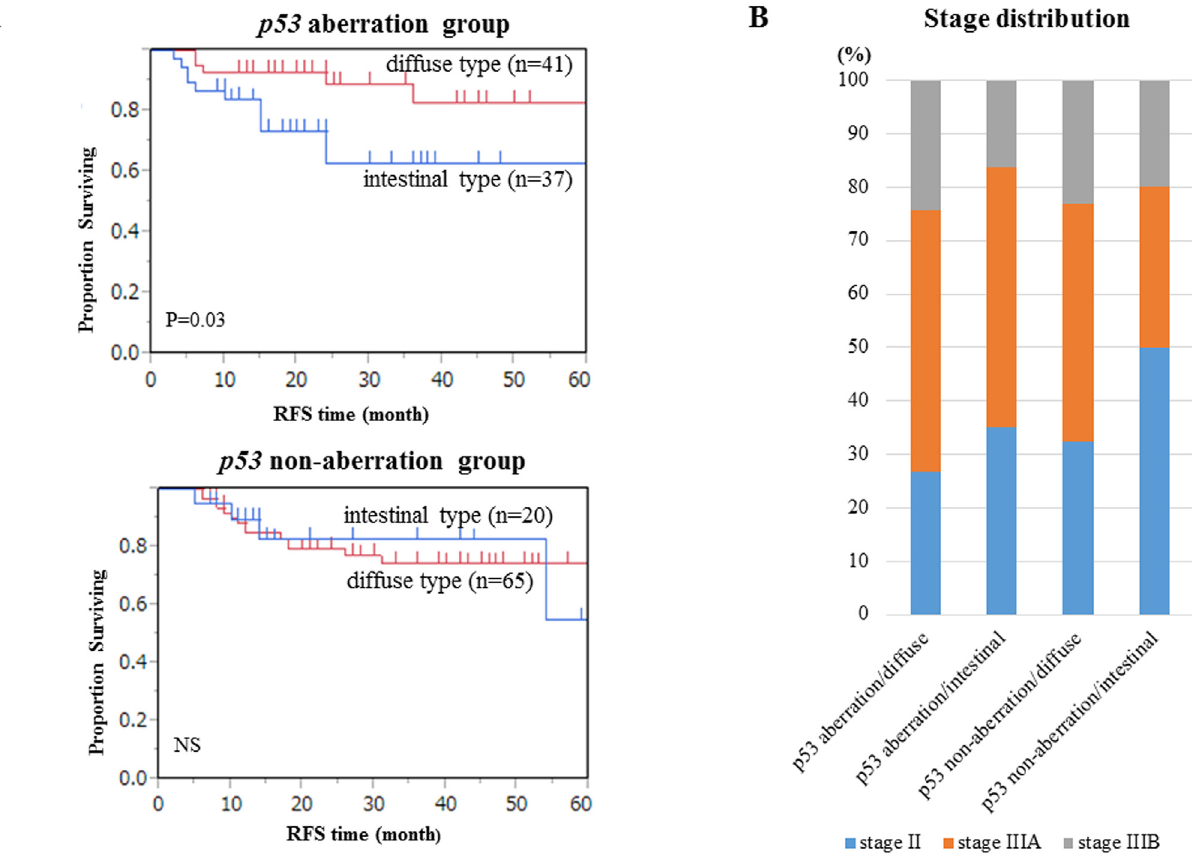
Fig 5. Kaplan-Meier analysis of 5 year RFS and Stage distribution in pStage II/III gastric cancer in the p53 aberrant and p53 non-aberrant groups. (A) Survival curves for intestinal type were compared with those of diffuse type gastric cancer with pStage II/III. (B) Cancer stage distribution according to the p53 aberration group and histological